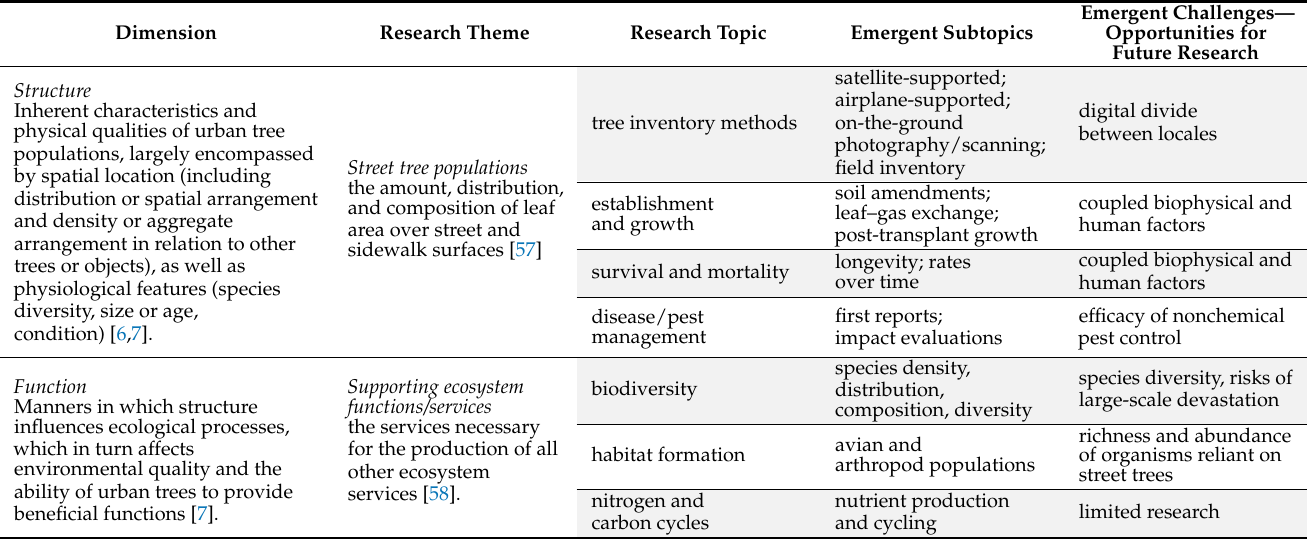
Table 1. Review sections and operating definitions/examples used to assess records of this litera- ture